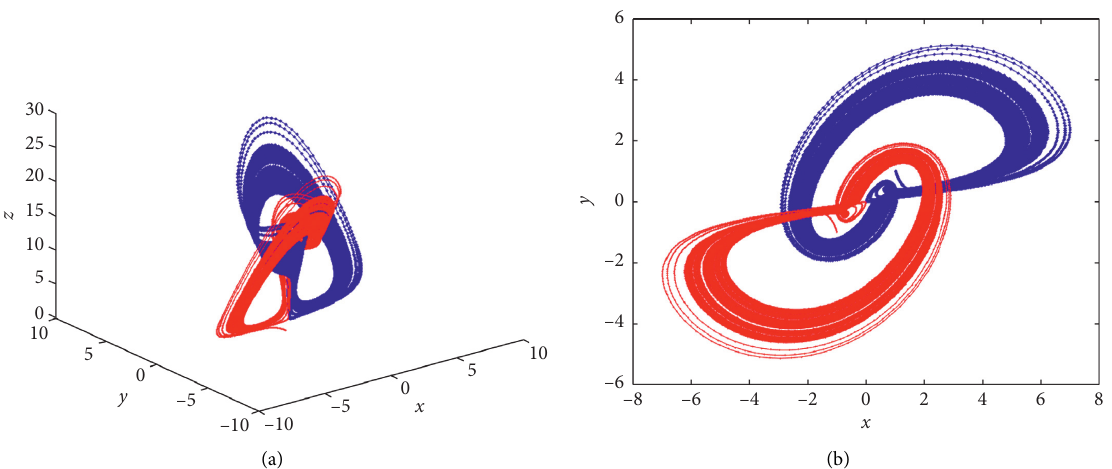
Figure 24: Coexisting attractors in ( x, y, z ) and ( x, y ) planes at α � 0 . 995.